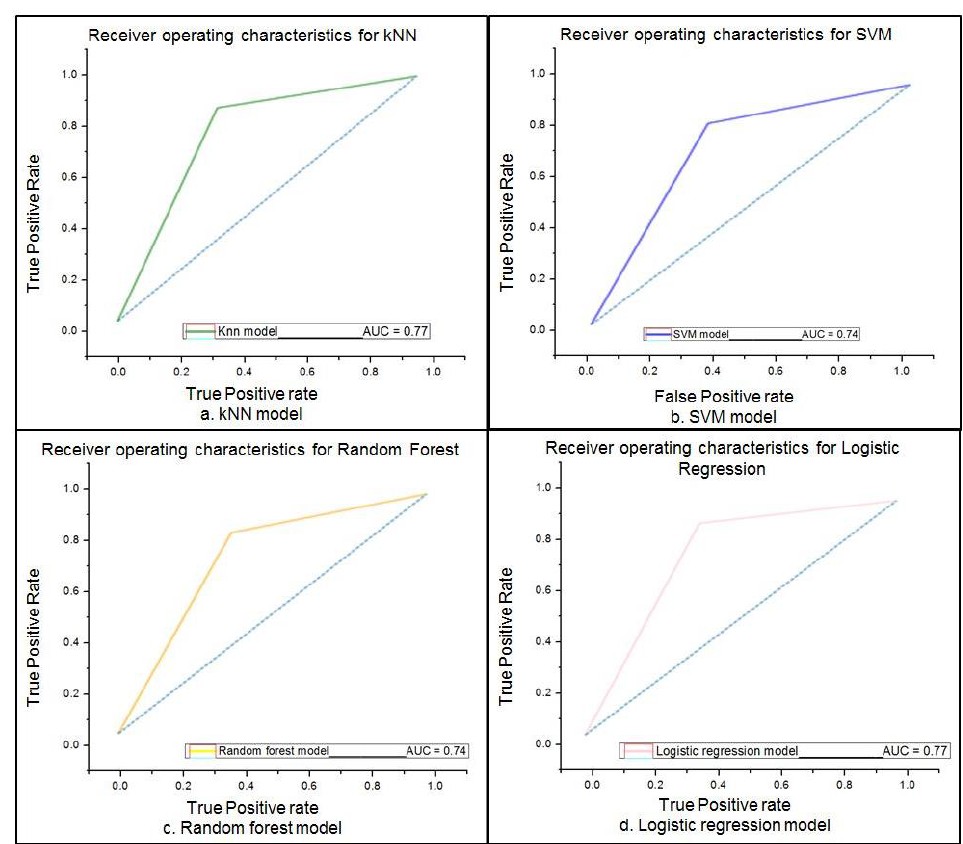
Figure 5. ROC curve for different ML models: a. kNN model; b. SVM model; c. Random forest model; d. Logistic regression